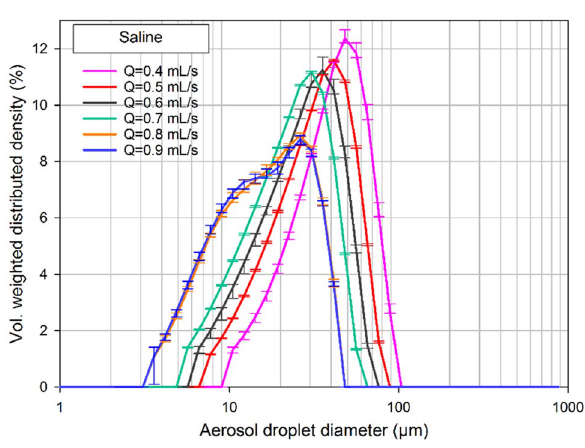
Figure 9. Comparison of aerosol deposition with varying liquid flow rate (Q) in four regions of the CFD box model, assuming a droplet diameter of ( A ) 1 µm, and ( B ) 30 µm.